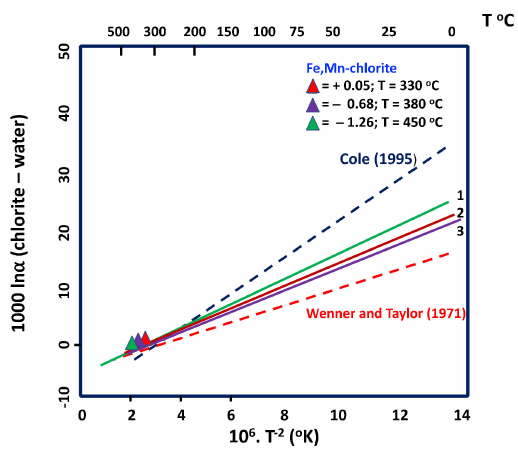
Figure 13. Estimation the oxygen isotope fractionation ratio between Fe,Mn-chlorite and water using the diagram of 10 6 × T − 2 ( ◦ K) vs. 10 3 ln α chlorite-water [53,66].